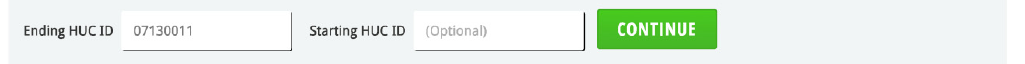
Figure 2. Initialization—watershed selection .